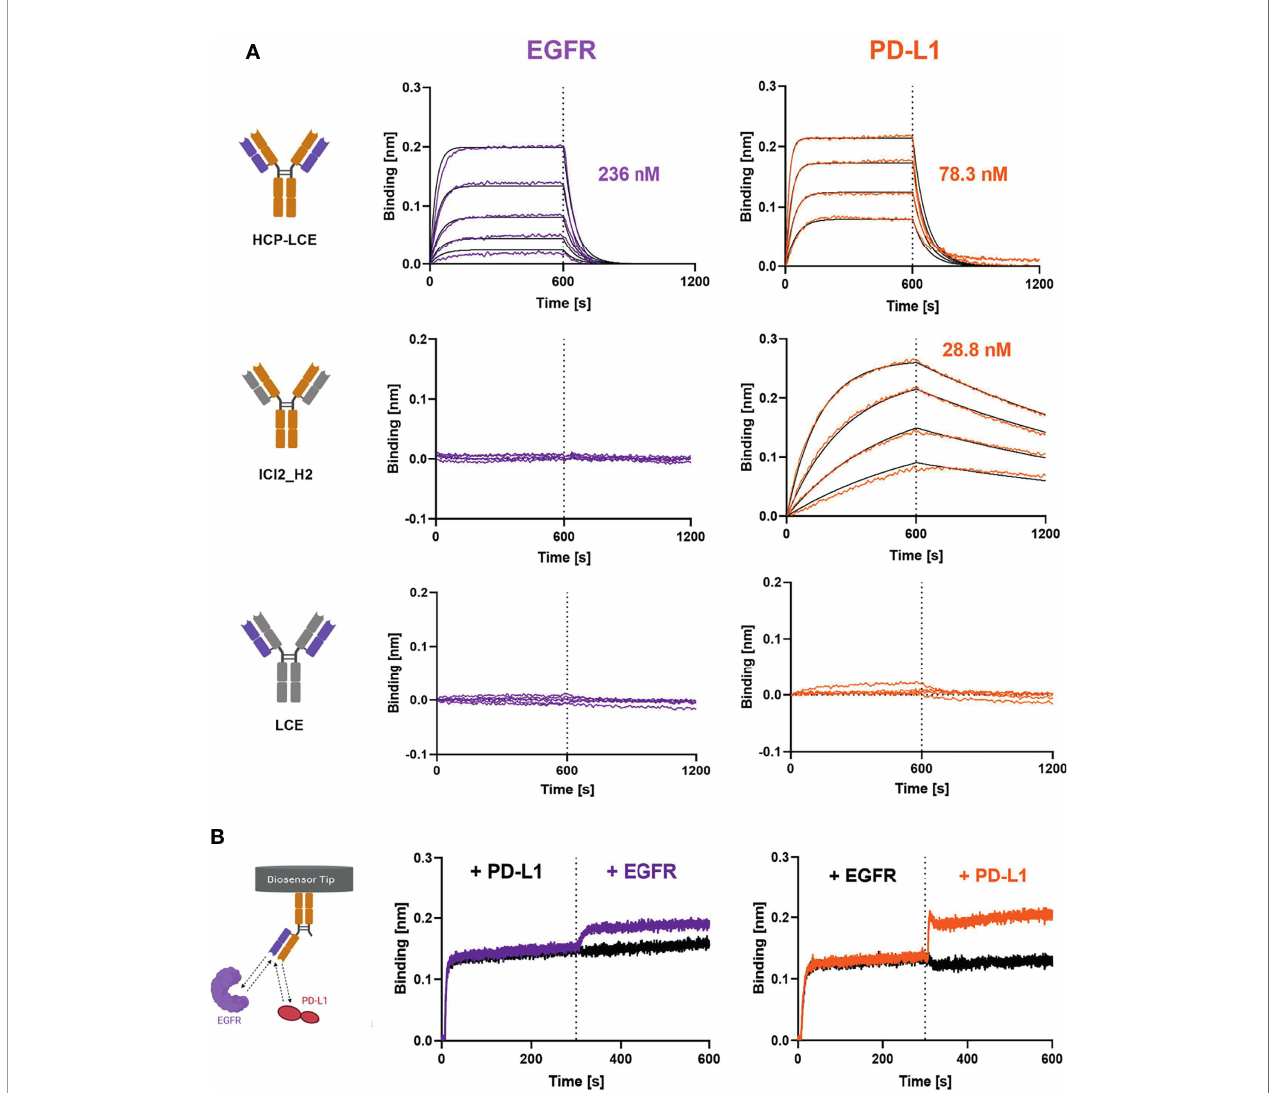
FIGURE 3 | Characterization of antigen binding of the Two-in-One antibody HCP-LCE by BLI-measurements. (A) BLI-measurements of HCP-LCE, ICI2_H2 and LCE against EGFR and PD-L1. HCP-LCE binds both antigens, whereas ICI2_H2 exclusively targets PD-L1. LCE shows no binding to either antigen. (B) BLI-assisted simultaneous binding assay. The one-armed HCP-LCE variant was loaded onto biosensors and antigens are added step-wise, revealing simultaneous EGFR and PD-L1 binding. Created with